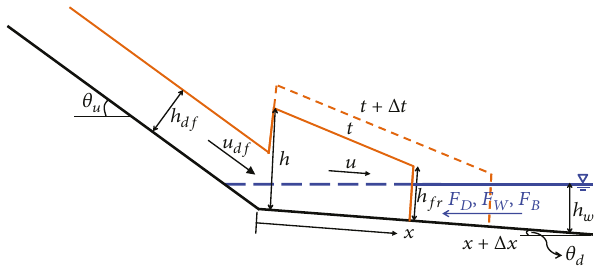
Figure 3: Process of the stoppage of the forefront of the tributary debris fl ow entering the main stream (modi fi ed from Takahashi